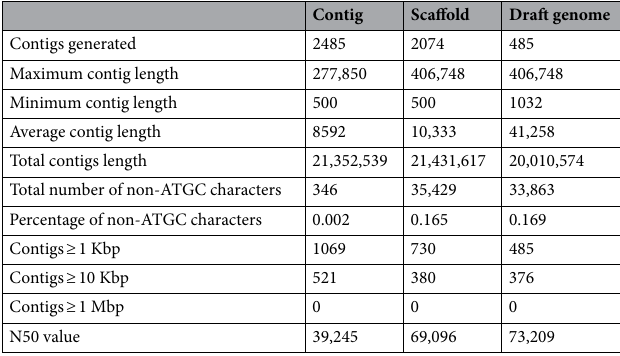
Table 2. Draft de novo genome assembly statistics of NCIM 3590.